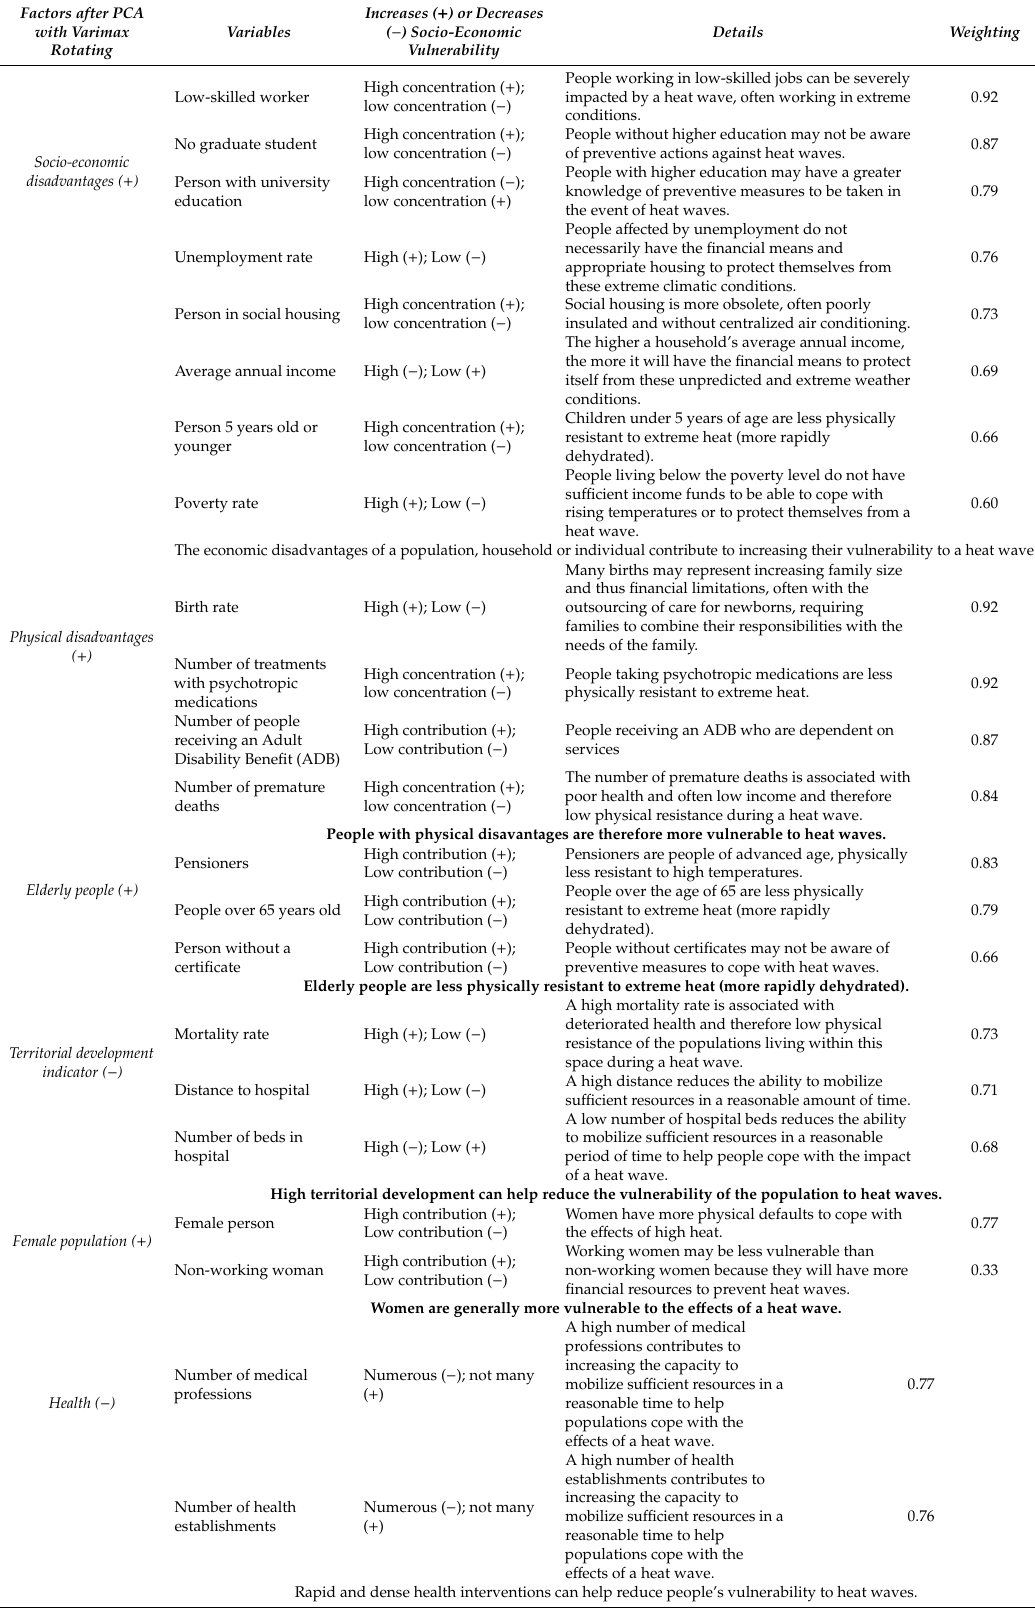
Table 4. Factors and variables retained after rotational PCA